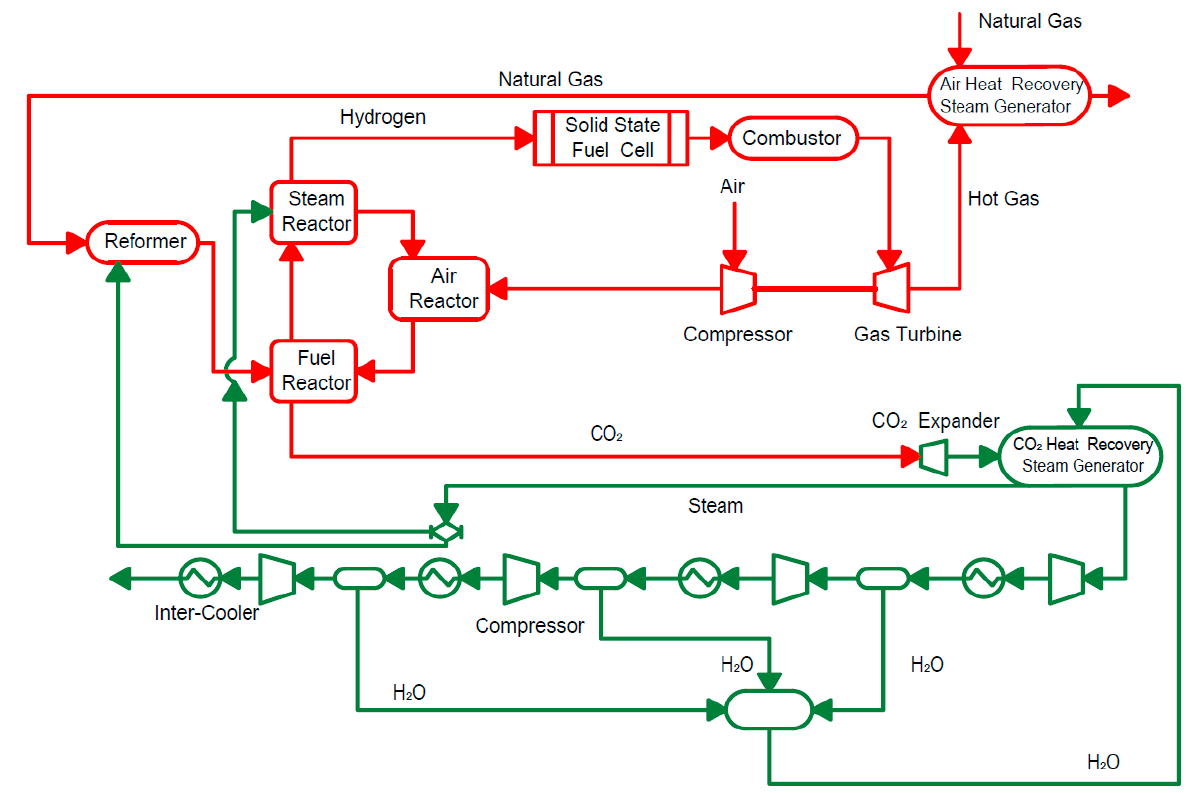
Figure 8. Hybrid power plant schematic (adapted from [88]).